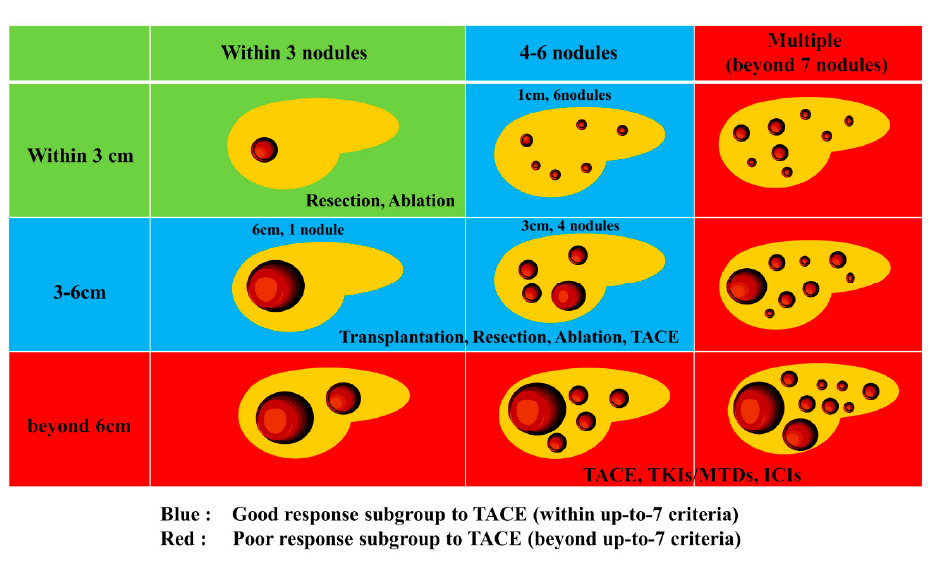
Figure 1. Heterogeneity and treatment strategy for intermediate stage HCC.